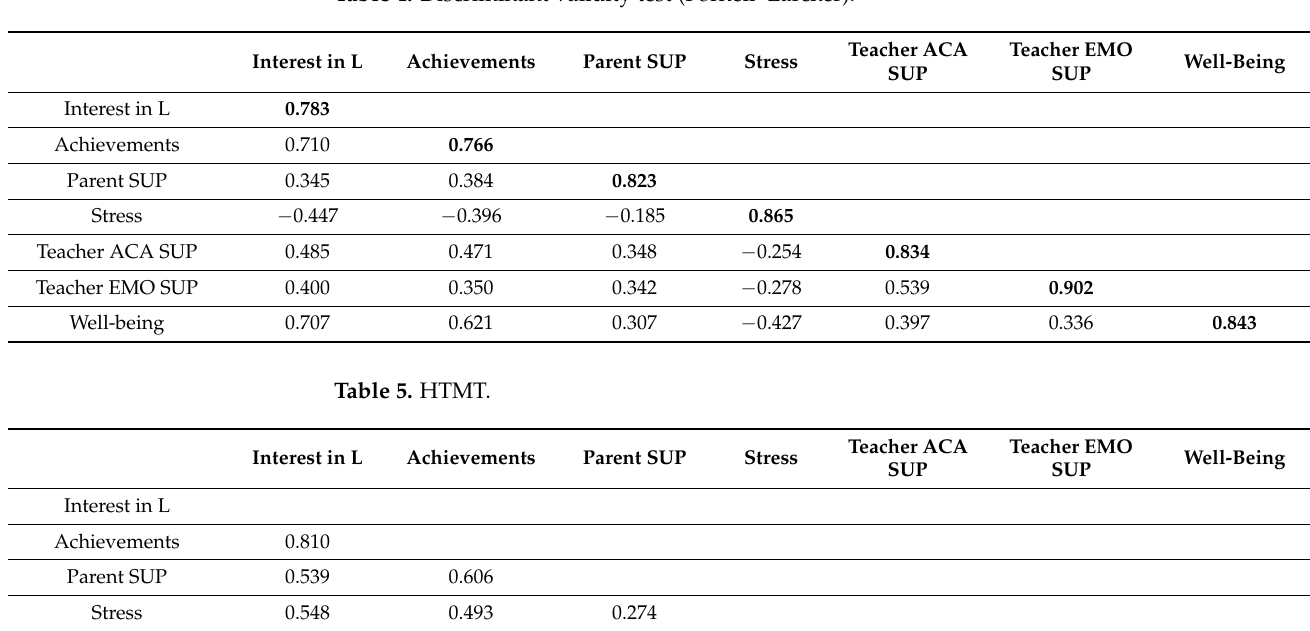
Table 4. Discriminant validity test (Fornell–Larcker).